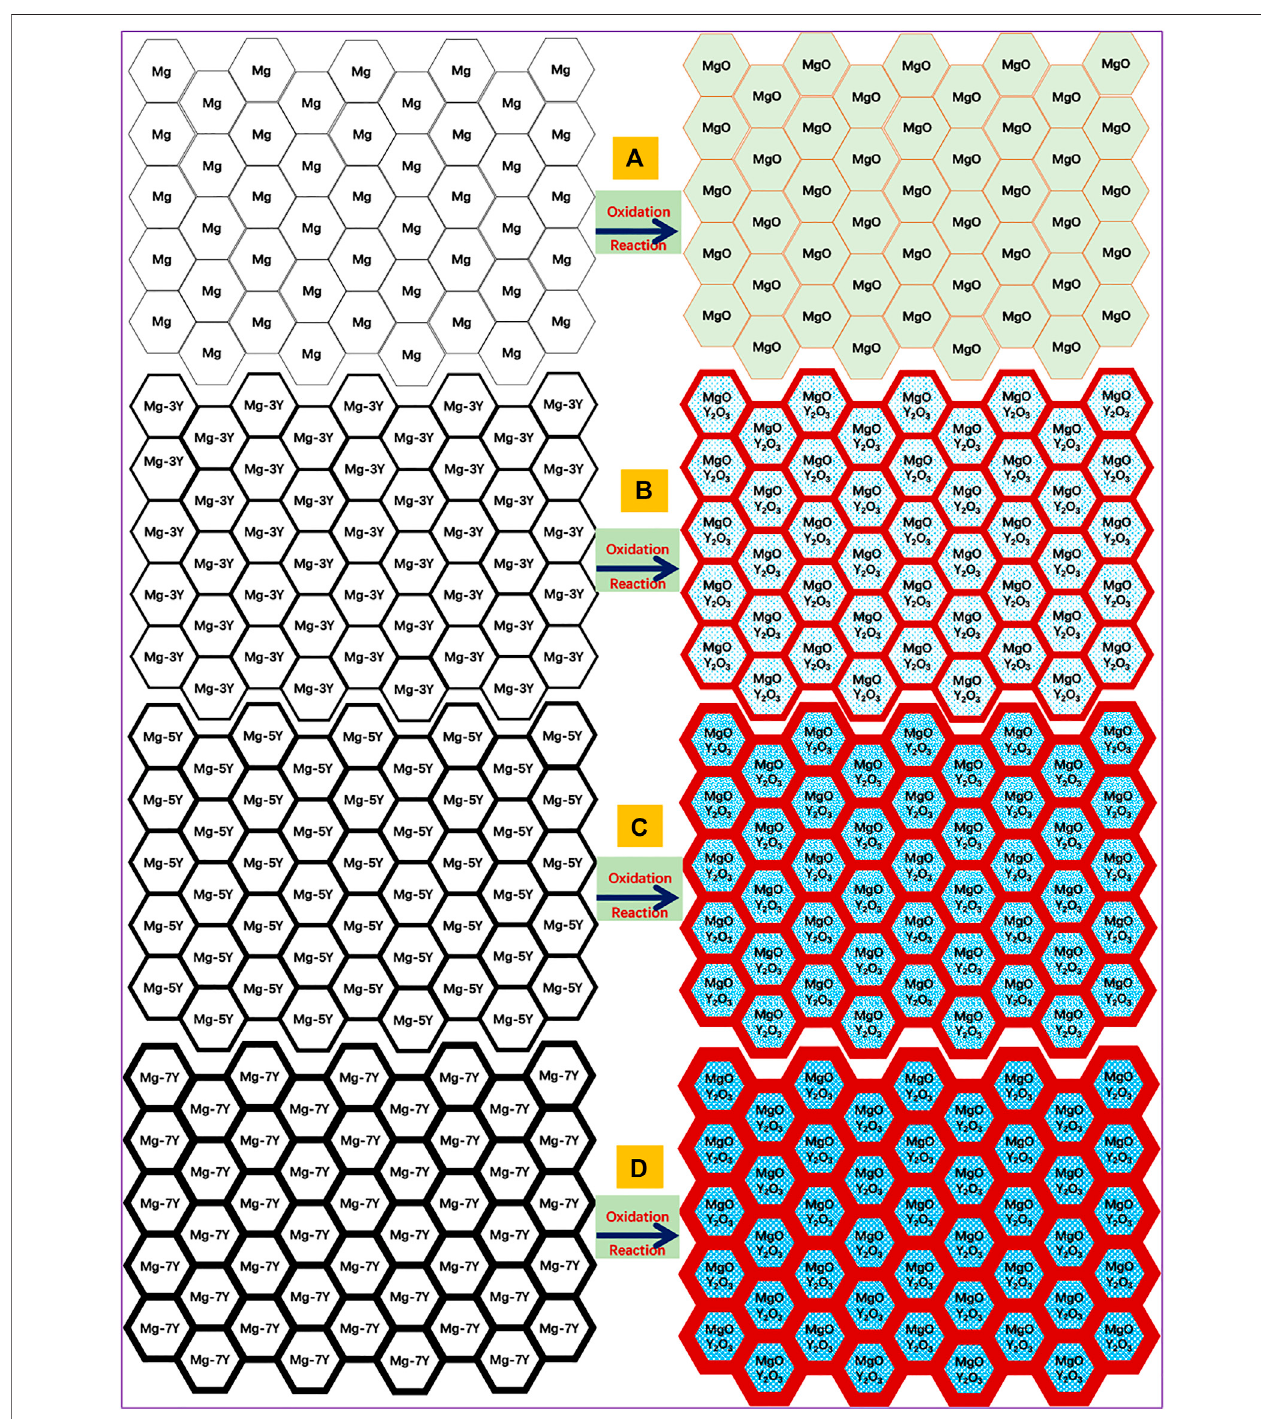
FIGURE 8 | The oxidation mechanism of pure Mg and Mg-Y alloys in this study.